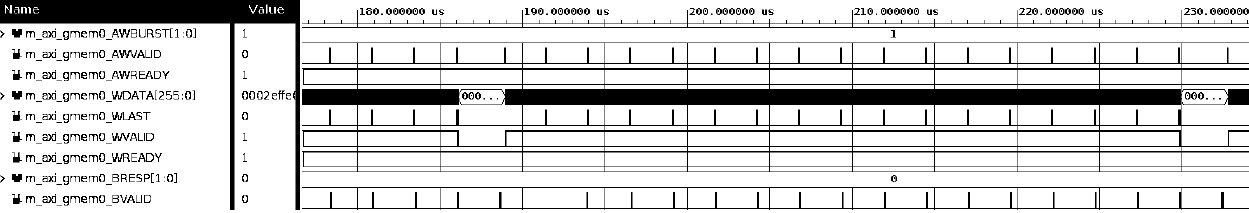
Figure 11. Results of simulation for a chunk length of 2048 words. Waveform displayed with GTKWave. Approximately 93% of the AXI bus bandwidth is used.